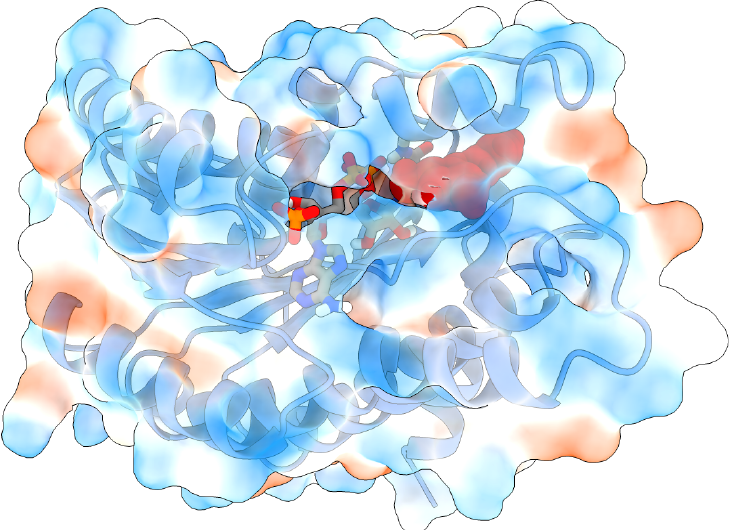
Figure 3. Initial structure of RES:11 β -HSD-1 complex for molecular dynamics simulations obtained by docking, showing 11 β -HSD-1 protein (PDB ID 4K1L), NADPH cofactor (licorice model), resveratrol (vdW model, red), and hydrophobic (blue surface) and hydrophilic (red surface) residues.